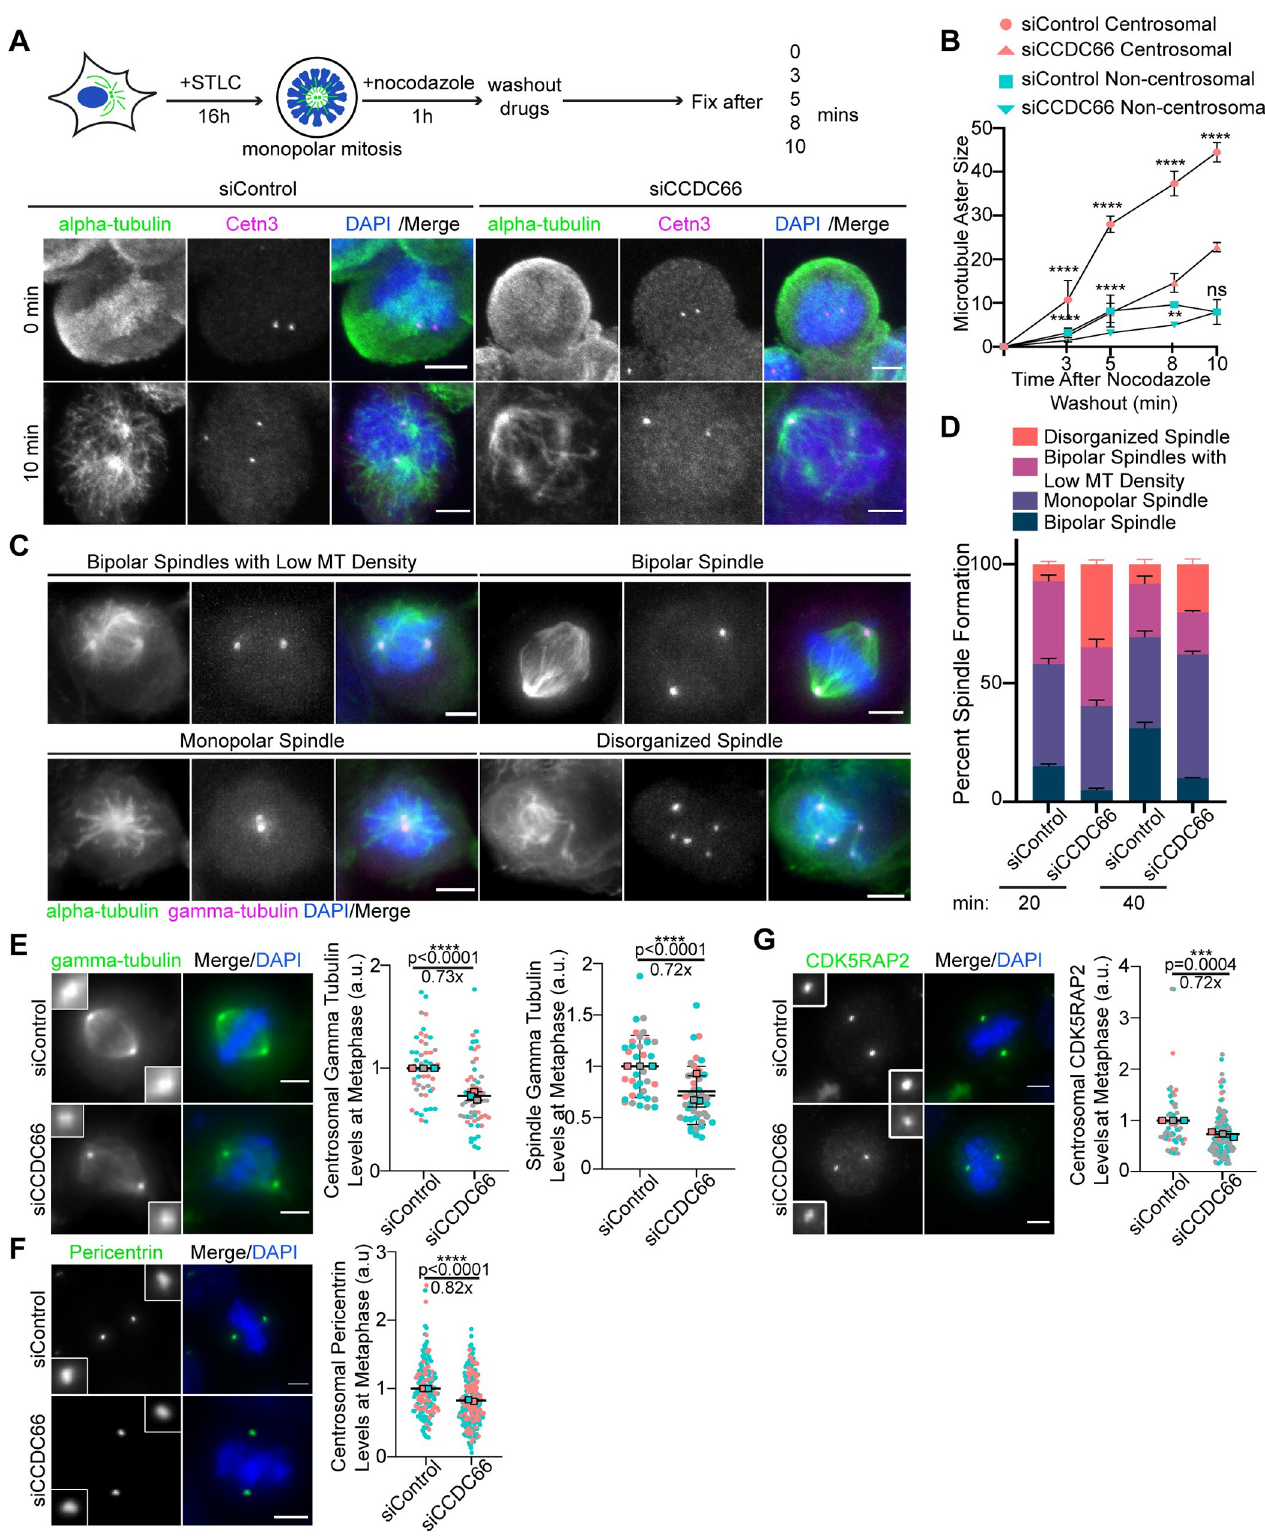
Fig 6. CCDC66 recruits core PCM proteins to the centrosome and is required for mitotic microtubule nucleation. (A) CCDC66 depletion slows down microtubule nucleation in mitotic cells. As illustrated in the experimental plan, U2OS cells were transfected with control and CCDC66 siRNA. Approximately